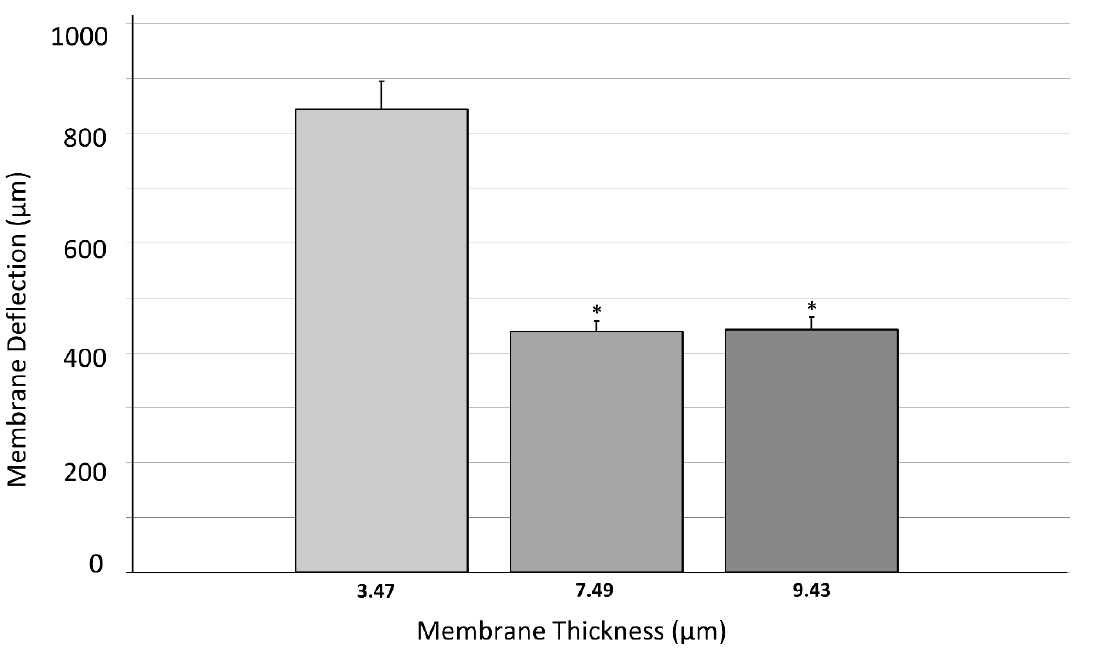
Figure 8. Dependency of membrane deflection on PDMS membrane thickness (thickness range = 3.24–10.06 µ m). Data were checked for normality using Shapiro–Wilk test ( n = 11 per group). Three different PDMS volumes were used to produce membranes with different thicknesses and their average deflection values were calculated. Error bars represent standard error of mean (SEM) for each group. One-way ANOVA test showed significant difference between groups 1–2 and 1–3 (4 and 8 µ L and 4 and 10 µ L PDMS volume group) with α = 0.01. Groups 2–3 (8–10 µ L PDMS volume) showed no difference through ANOVA. (* p < 0.01 vs. Group 1). Table 5. Measured average deflection values of membranes with average membrane thick- nesses ± standard deviation in µ